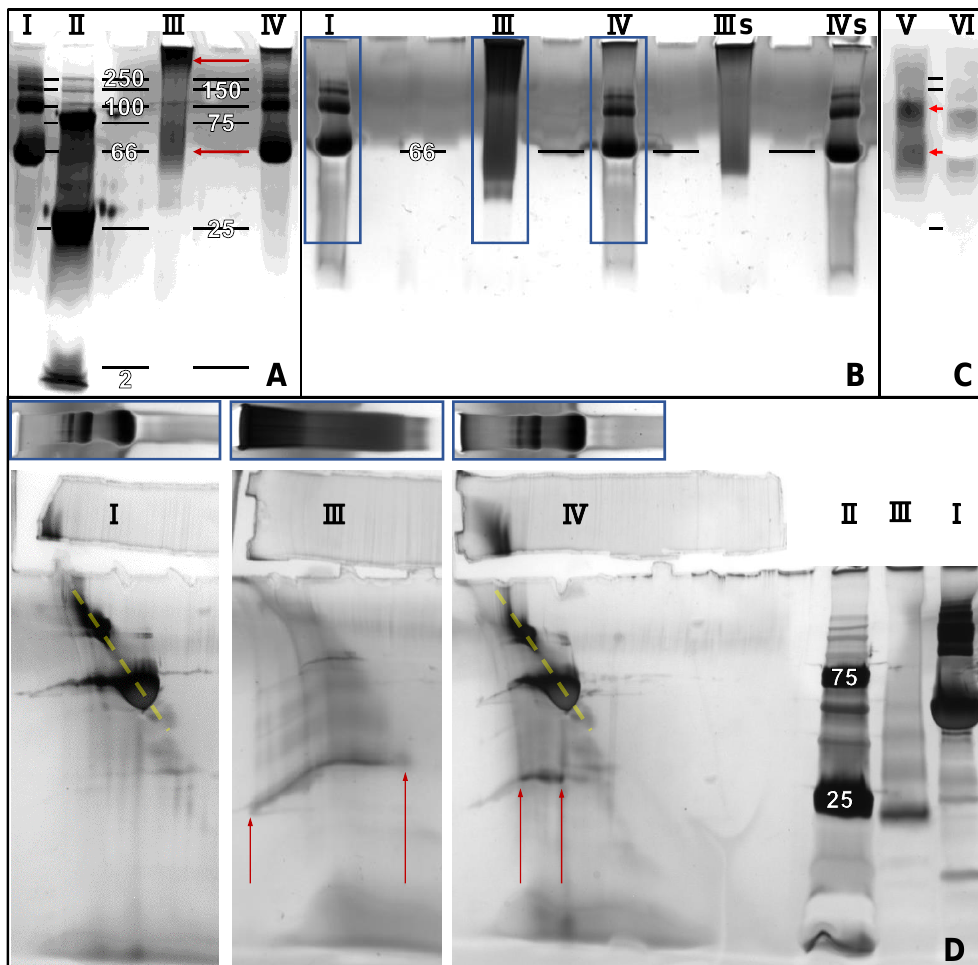
Figure 5. ( A , B ) silver-stain and ( C ) Western blot of blue native PAGEs. ( D ) Silver-stain of three second dimension gels of 2D Blue Native / SDS-PAGEs. Darker grey value corresponds to higher degree of light attenuation during transillumination ( A , B , D ) or to higher relative luminescence ( C ). Blue boxes indicate where the lanes were cut out of the blue native PAGE and how they were applied on the second dimension SDS-PAGEs. White labels indicate approximate molecular mass (kDa). Red arrows highlight distribution of BMP-2. I = 30 µg BSA, II = Ladder, III = 2 µg BMP-2, IIIs = 0.5 µg BMP-2, IV = I + III, IVs = I + IIIs, V = 16 ng BMP-2, VI = V + 10 µg BSA. As expected, albumin and the larger serum proteins were found on a diagonal line (highlighted by dashed yellow lines) because they had been separated twice by their different protein sizes (lane